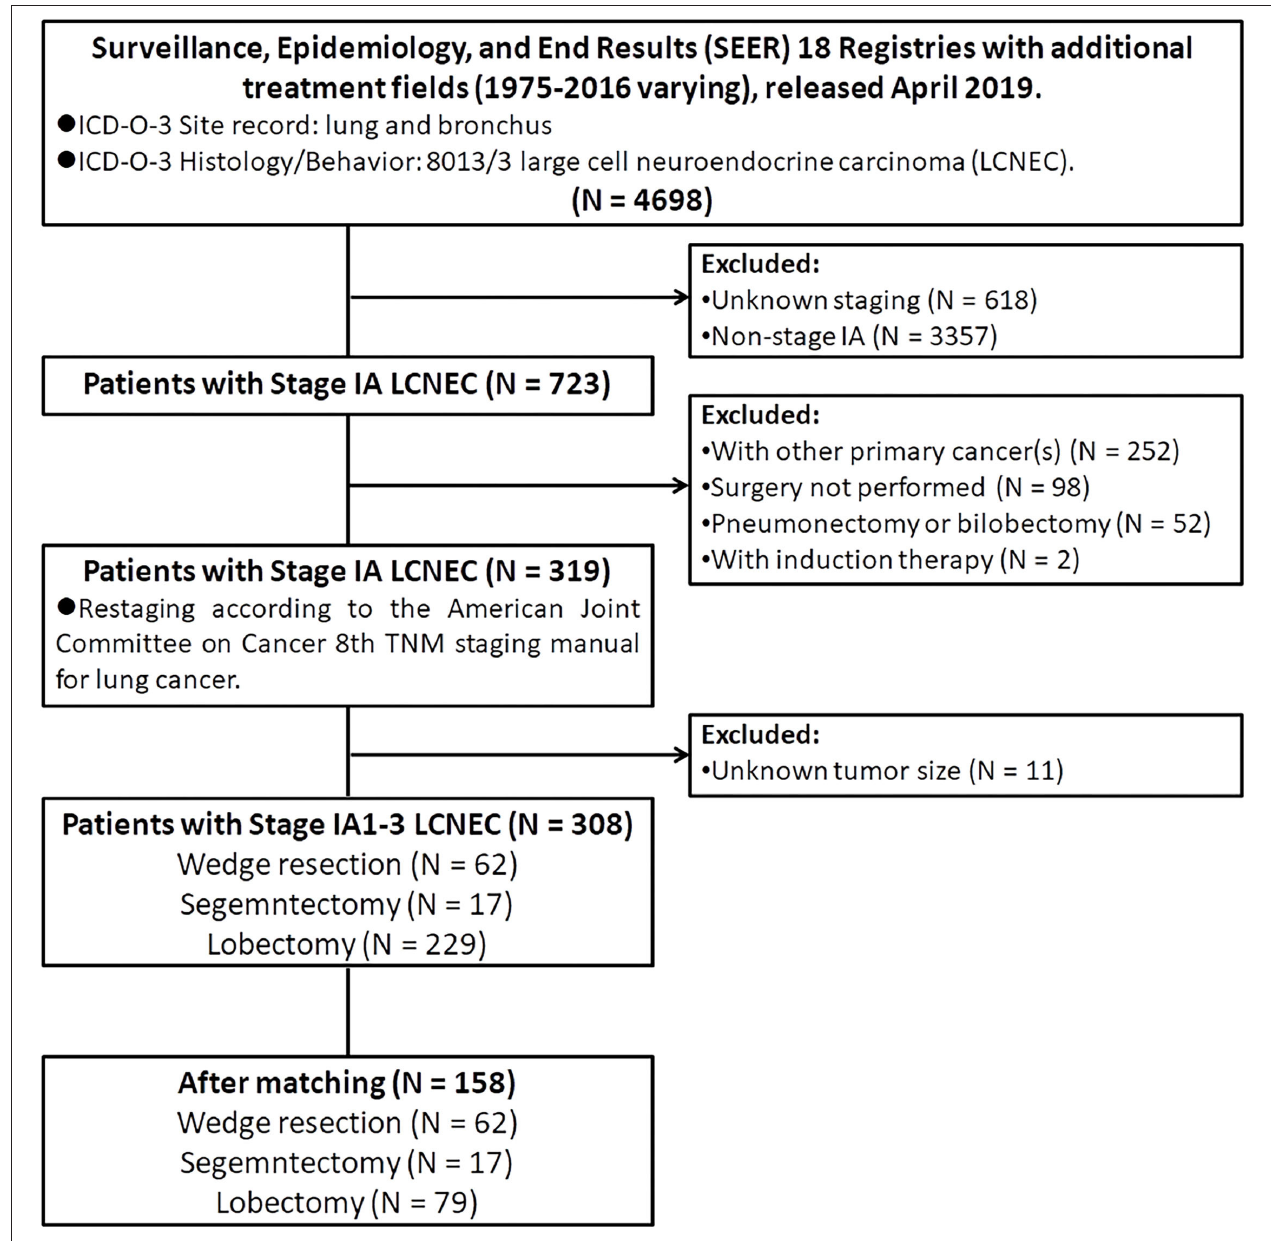
FIGURE 1 | The flow diagram of the selection process for this population-based study cohort.